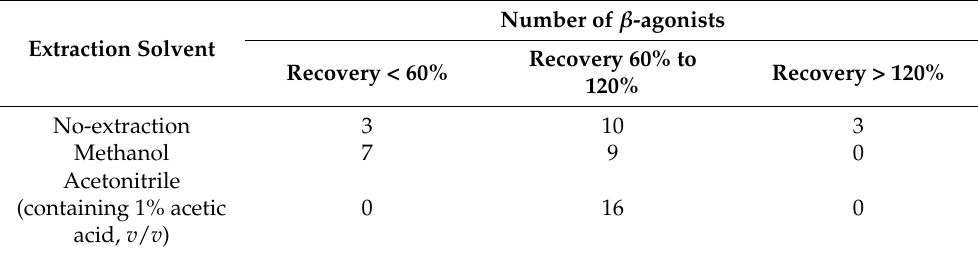
Table 3. Effect of extraction solvent on the recovery sixteen β